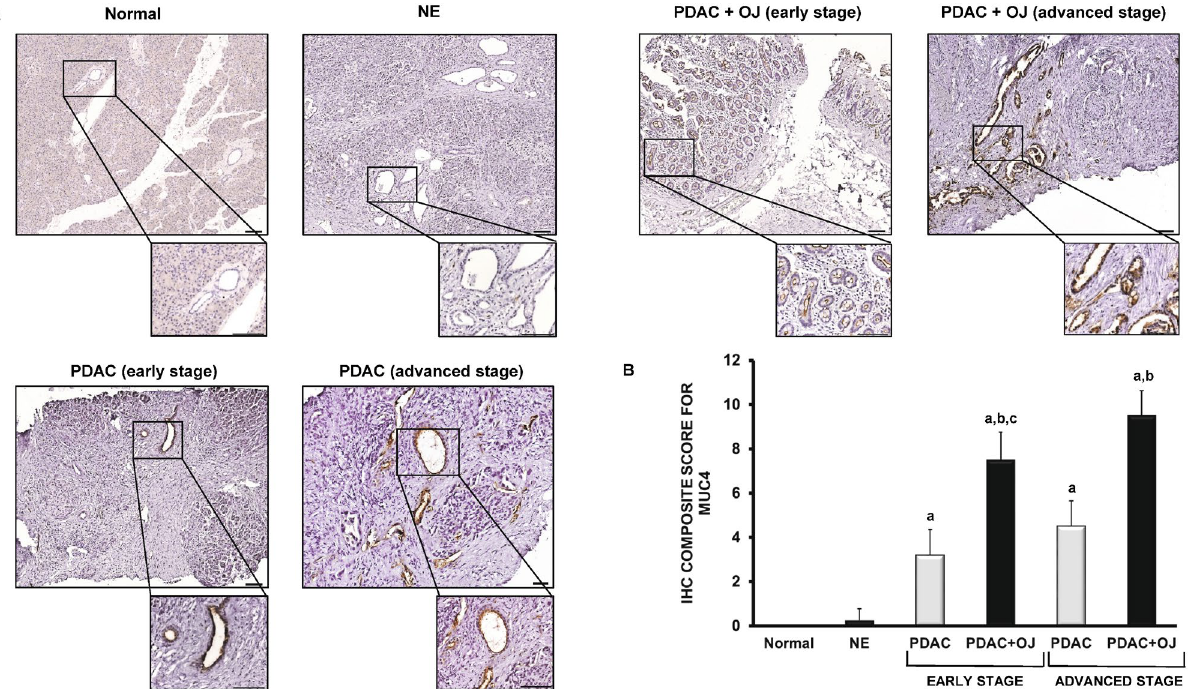
Figure 5. Expression of MUC4 in human pancreatic samples. ( A ) Representative immunohistochemical stainings show the presence of MUC4 in human pancreatic samples. ( B ) Composite scores of human pancreatic samples stained with anti-MUC4 antibody. Data represent mean ± SEM of 23–25 specimens/4–25 patients each group. a = p ≤ 0.05 vs. normal, b = p ≤ 0.05 vs. PDAC, c = p ≤ 0.05 vs. advanced stage. Scale bar represents 100 µm. PDAC pancreatic ductal adenocarcinoma; OJ obstructive jaundice; NE neuroendocrine tumour.